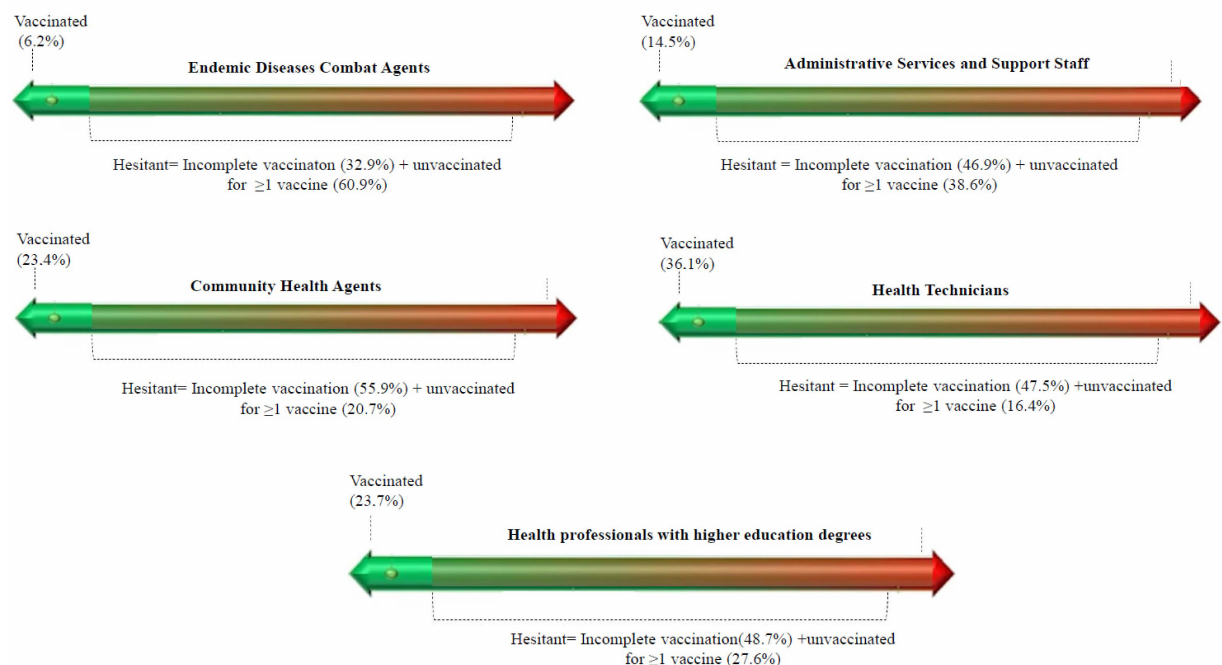
Figure 1. Prevalence of complete vaccination schedule, incomplete vaccination schedule and nonvac- cination for at least one immunizer according to occupational categories in Bahia, Brazil, in 2020.